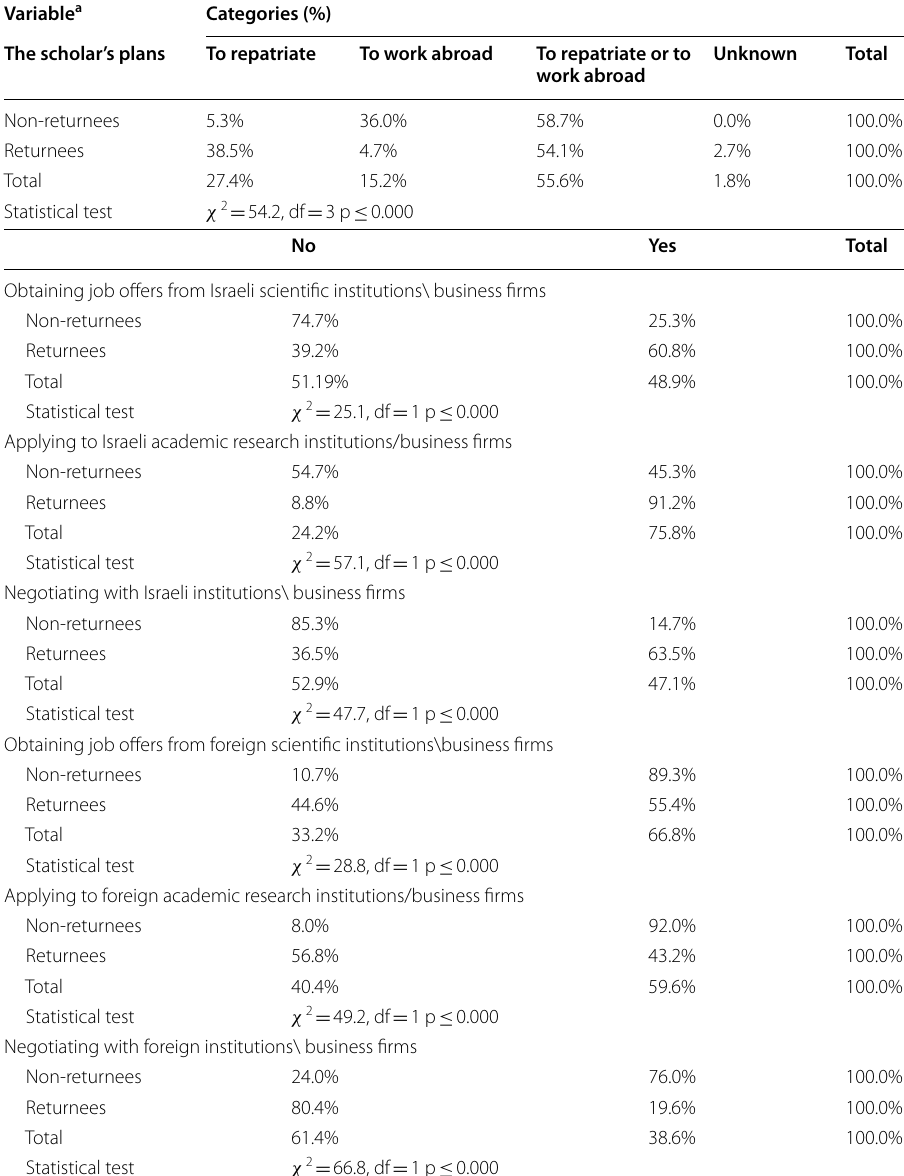
Table 3 Group differences between non-repatriating and repatriating scholars regarding international mobility (Chi-Square